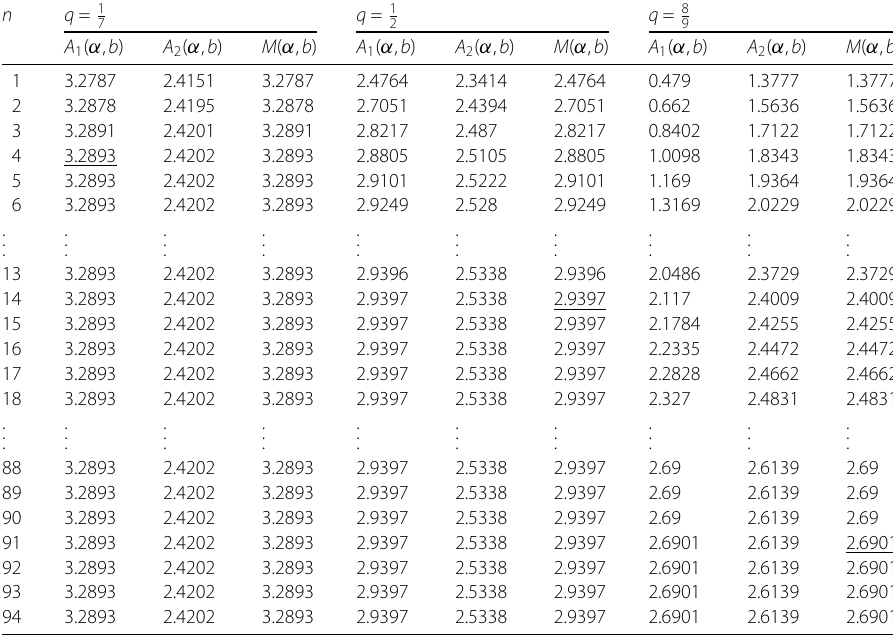
Table 8 Some numerical results of M ( α , b ) in equation (31) in Example 2 for q = 1